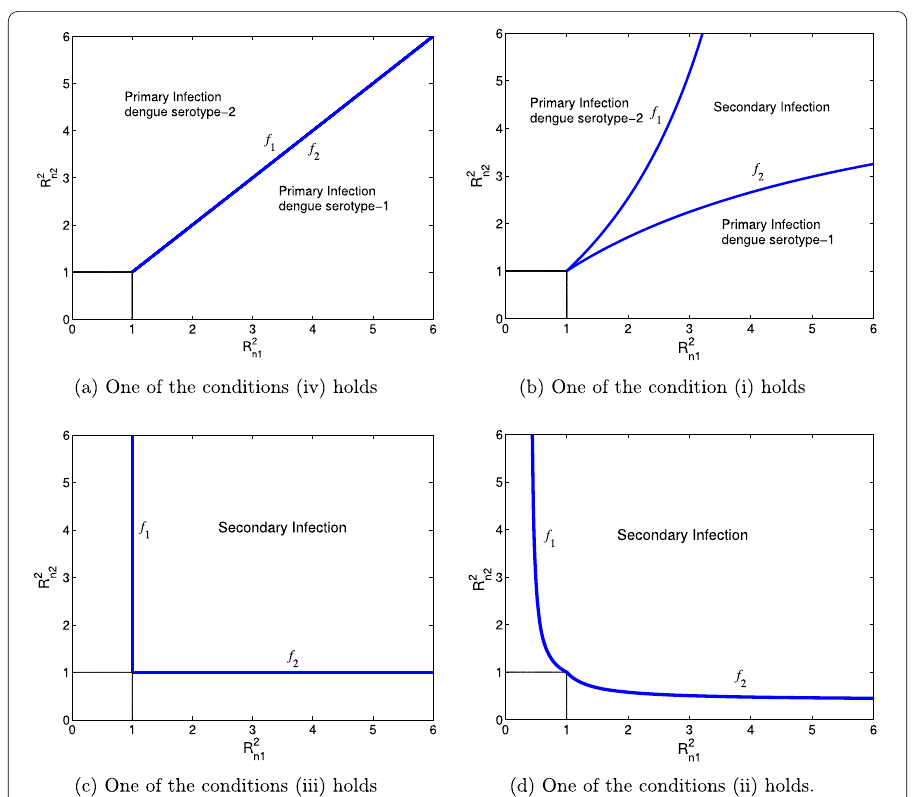
Figure 5 Showing the region of primary and secondary infections which are separated by the functions f 1 and f 2 given in (4.4) under the condition in Lemma